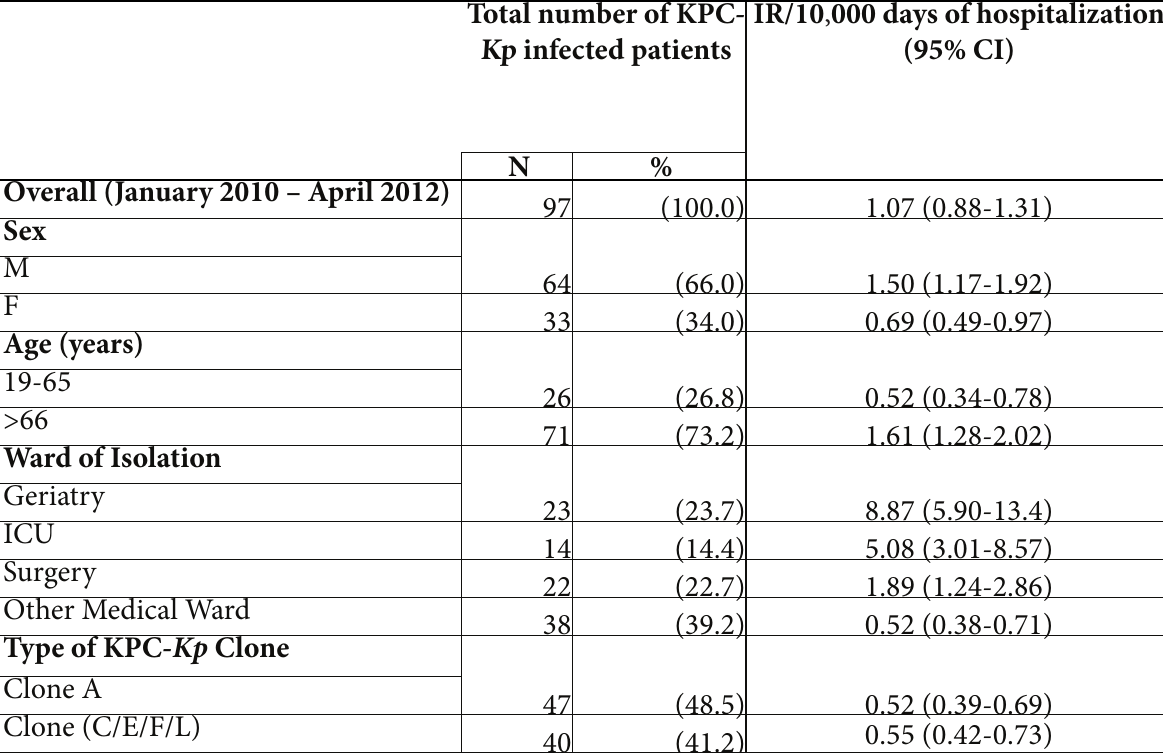
Table 1. Incidence rate of KPC- Kp infection/10 , 000 days of hospitalization (IR), overall and in strata of age, ward of isolation, and diagnoses at